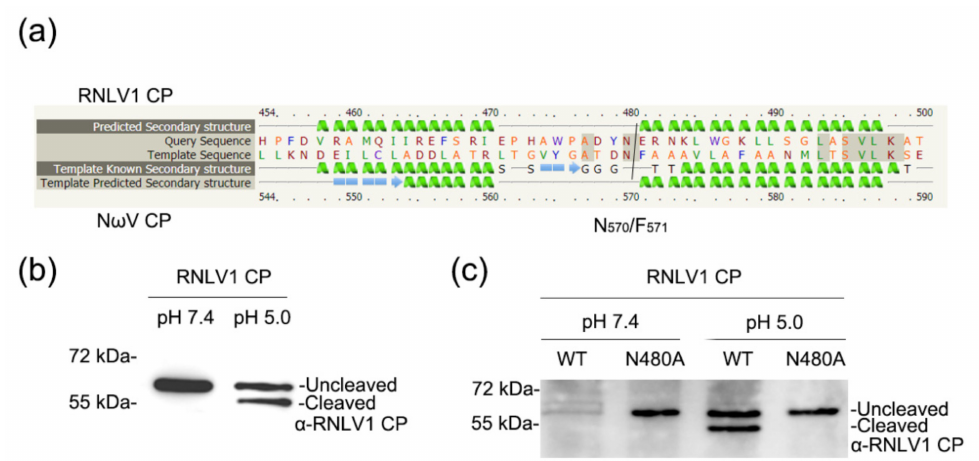
Figure 7. Analysis of RNLV1 CP self-cleavage. ( a ) Sequence alignments of RNLV1 CP and N ω V CP using Phyre2 service. ( b ) Western blot assay analyzing the self-cleavage of RNLV1 CP from the transfected Sf9 cells. Extracts were incubated in a weakly alkaline (pH 7.4) or acidic environment (pH 5.0) at room temperature for 1 d and then analyzed through Western blot assay using a polyclonal antibody against RNLV1 CP. ( c ) Western blot assay analyzing the self-cleavage of RNLV1 CP WT and the mutant RNLV1 CP N480A from N. benthamiana leaves agro-infiltrated with pGD-RNLV1 CP WT and pGD-RNLV1 CP N480A . At 3 dpi, extracts were incubated in a weakly alkaline (pH 7.4) or acidic environment (pH 5.0) at room temperature for 1 d and then analyzed through Western blot assay using a polyclonal antibody against RNLV1